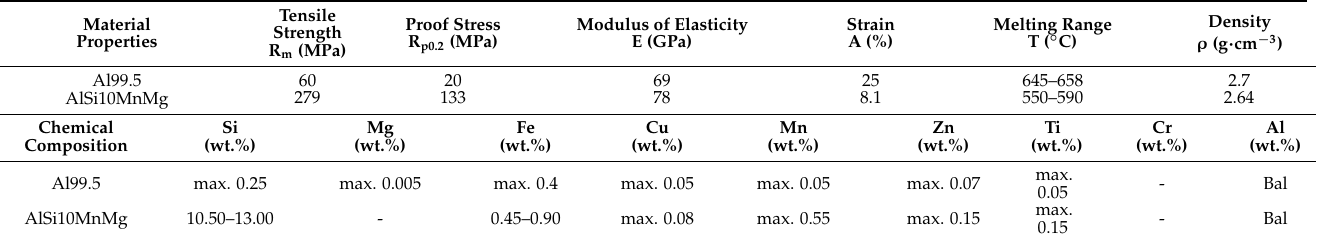
Table 1. Material properties and chemical composition of Al99.5 and AlSi10MnMg (according to the manufacturer).